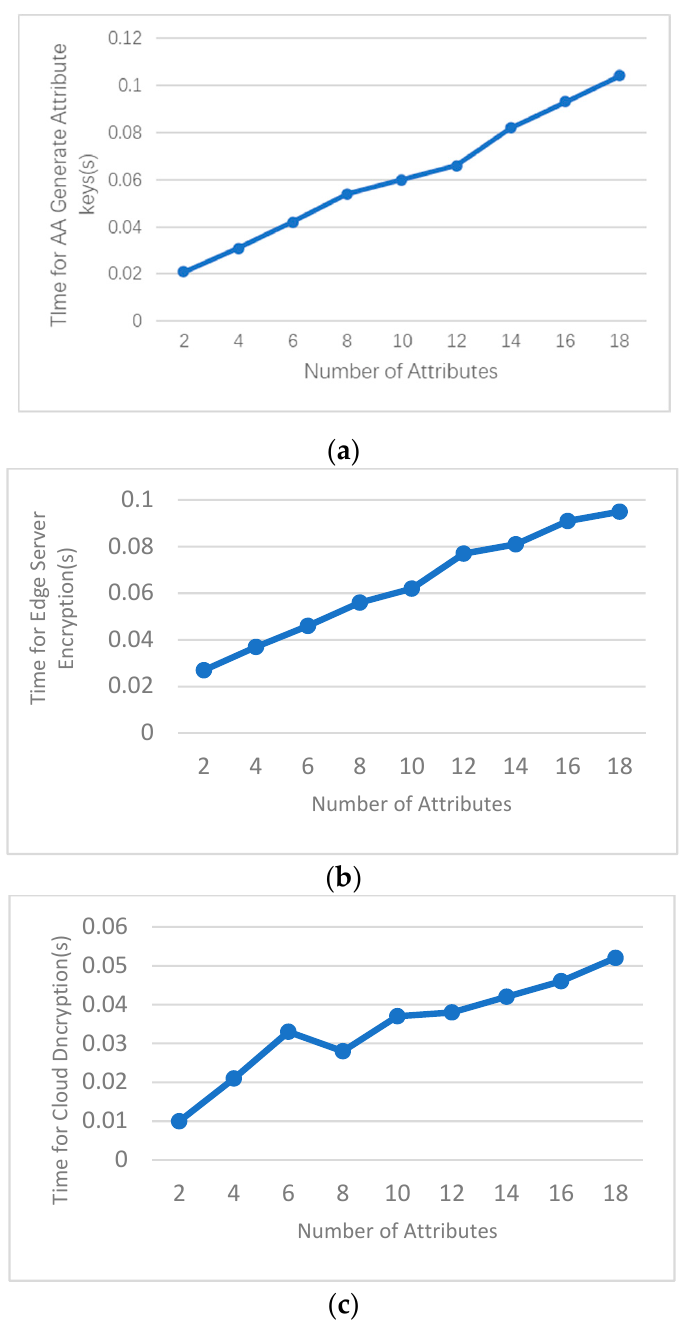
Figure 4. Time cost for ( a ) AA to generate attribute keys; ( b ) edge server encryption; and ( c ) cloud decryption; with different number of attributes.